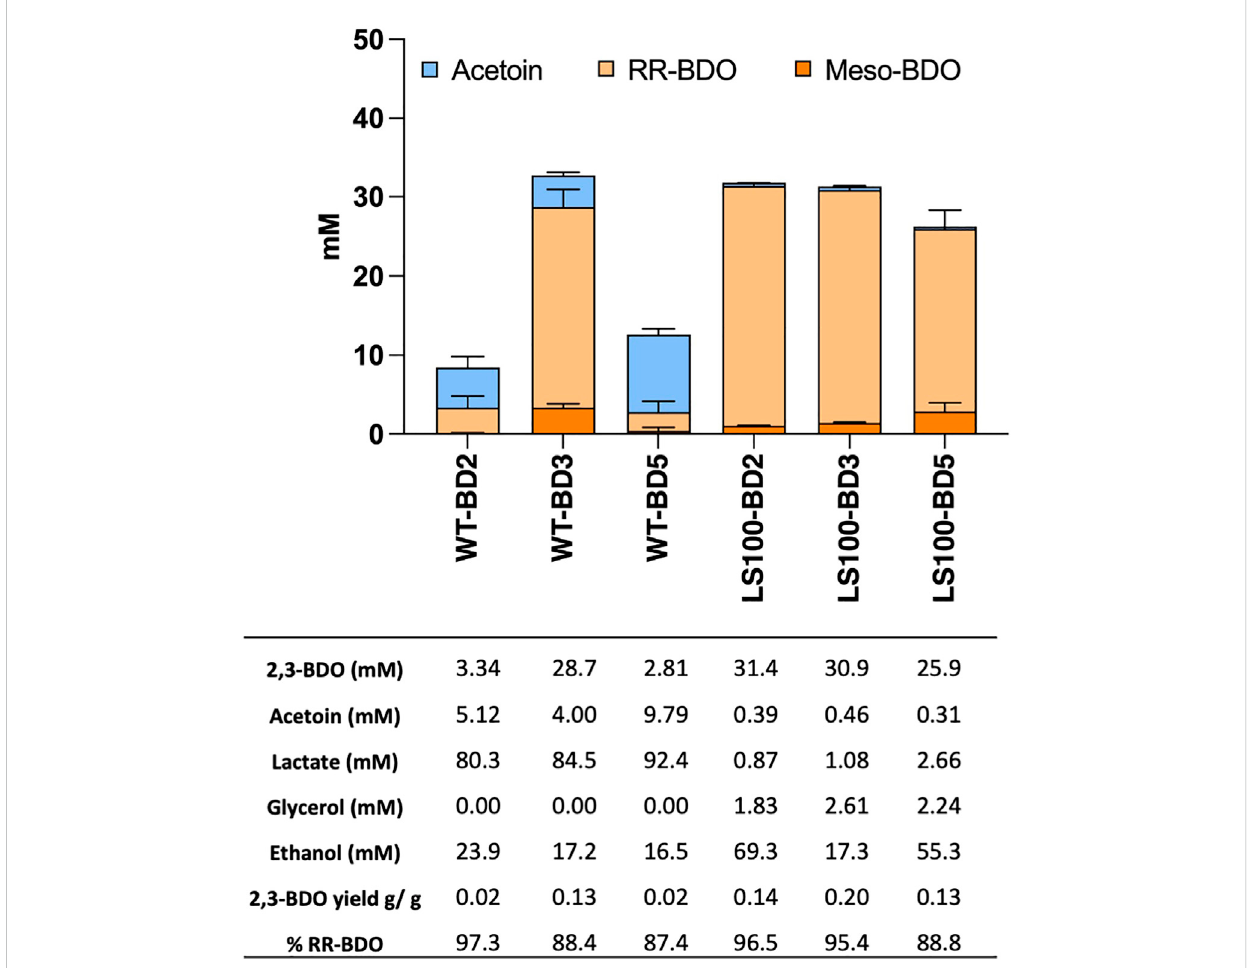
Product pro fi lesofthe P. thermoglucosidasius WTand LS100( Δ ldh Δ p fl )doublemutantstraincarryingtheassembled,plasmid-based,heterologous acetoin/2,3-BDO pathways. Strains carried either plasmids pMTL-BD2, pMTL-BD3 or pMTL-BD5. Cultures were grown for 48 h in 10 mL of M-ASYE medium containing 2% (w/v) yeast extract and 2% (w/v) glucose in 50 mL falcon tubes at 50 ° C with shaking (250 rpm). Concentrations are calculated as the average three biological replicates. Error bars represent the standard deviation. BDO = 2,3- butanediol, RR-BDO = RR-2,3-butanediol, meso- BDO = meso-2,3-